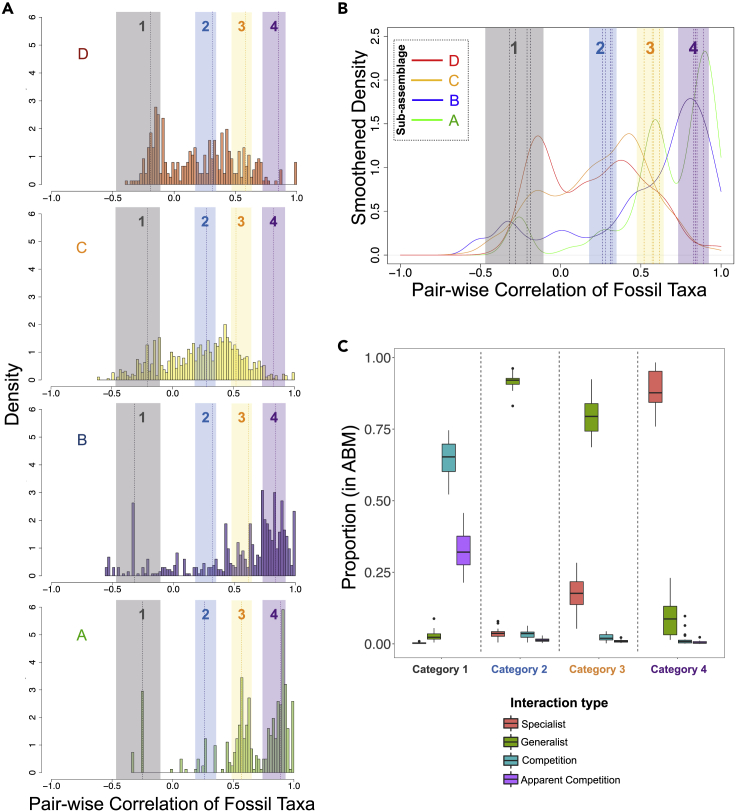
Characterization of interactions(A) Distribution of pairwise correlations across A–D; dotted lines indicate the means of the basis Gaussians in each sub-assemblage calculated using maximum likelihood analysis for decomposing the abundance correlation distributions; colored bands indicate the four interaction categories 1–4, which represent the range of the Gaussian means for each interaction type, clustered from the basis Gaussians of the running time frame analysis using spectral analysis with gap statistics (see methods).(B and C) (B) Summary of the four categories of interactions, calculated from spectral analysis, on the smoothened density distributions of pairwise correlation of fossils in the four sub-assemblages A–D; dotted lines indicate the means of Gaussian basis distributions from A–D; (C) Proportion of different feeding types in the ABM whose abundance correlations fall in the colored bands identified in (A), suggesting, for example, that the negative correlations in category 1 (gray) are dominated by competition and apparent competition interactions, whereas the strongly positive correlations in category 4 (purple) derive from specialized interactions.